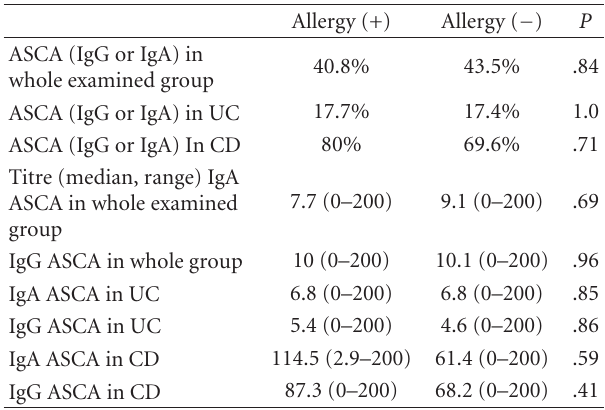
Table 1: Relation between the frequency of occurrence and titre of ASCA antibodies and food